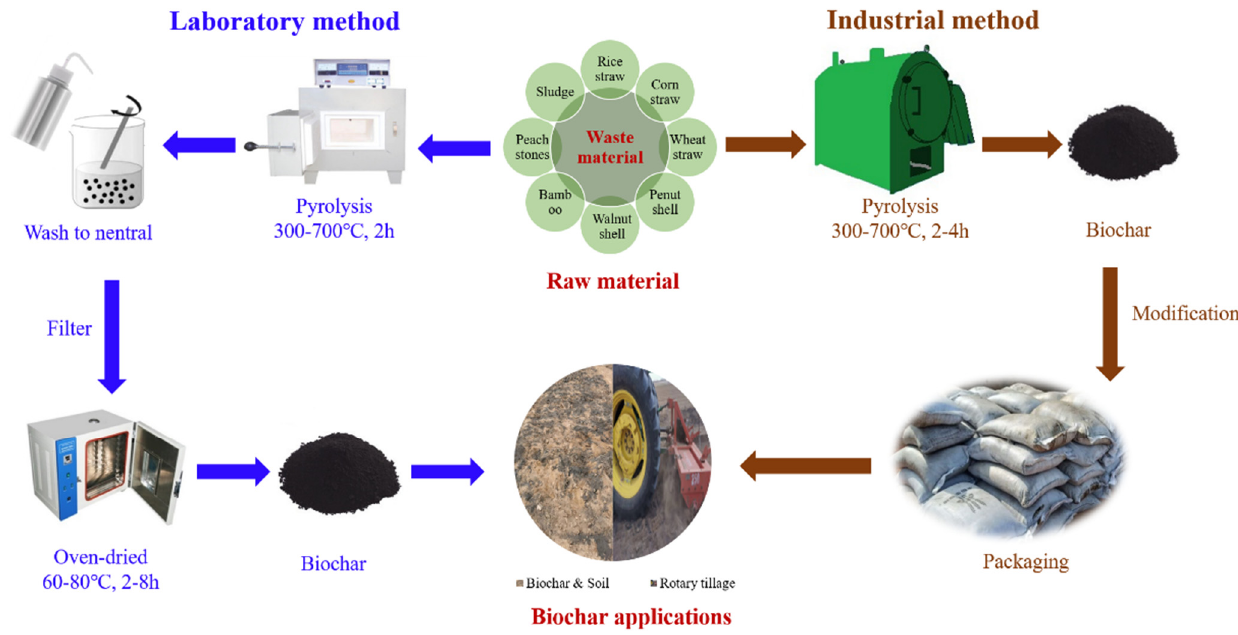
Figure 1. Procedure for biochar preparation and application.